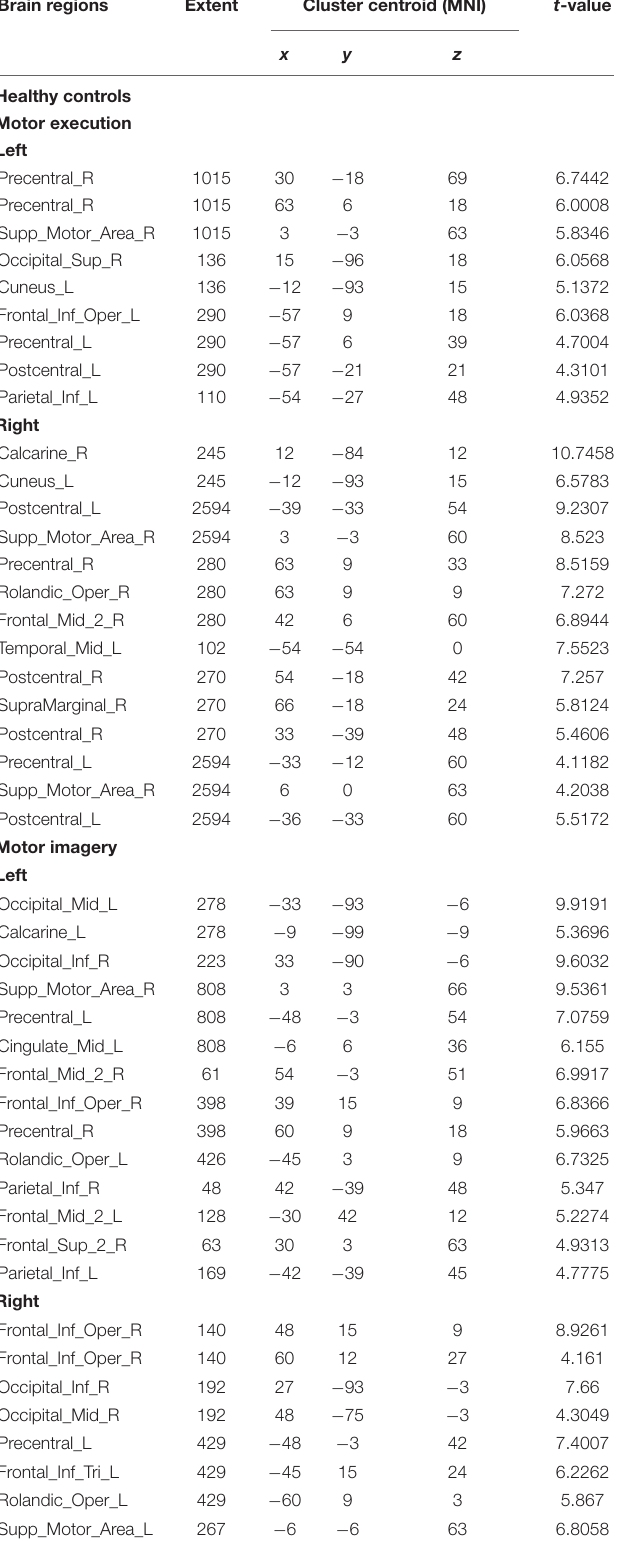
TABLE 2 | Group activation maps and the corresponding MNI coordinates. Brain regions